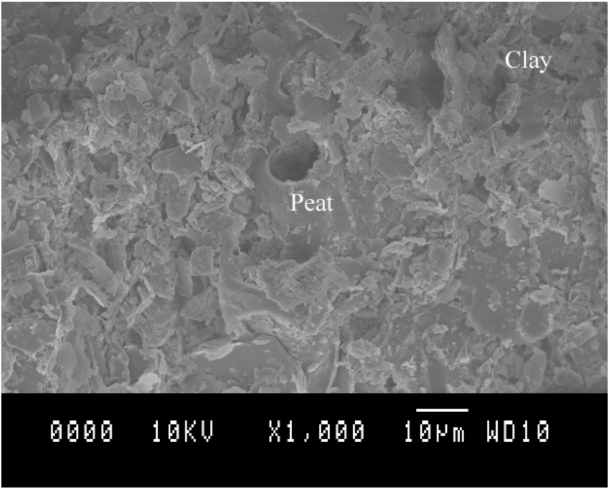
Figure 16. Micrograph of the medium-organic clay ( OH-1 ) studied at a magnification of 1000.